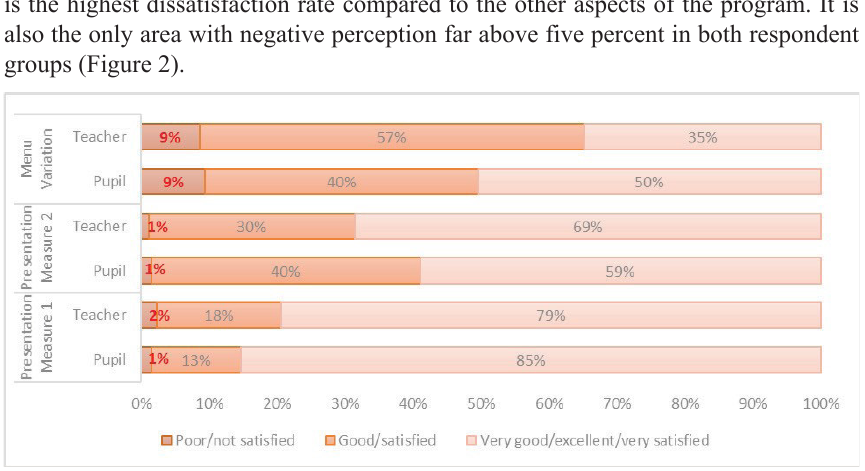
Fig. 2: Perception of the Food Presentation and Menu Variation Source: Field survey